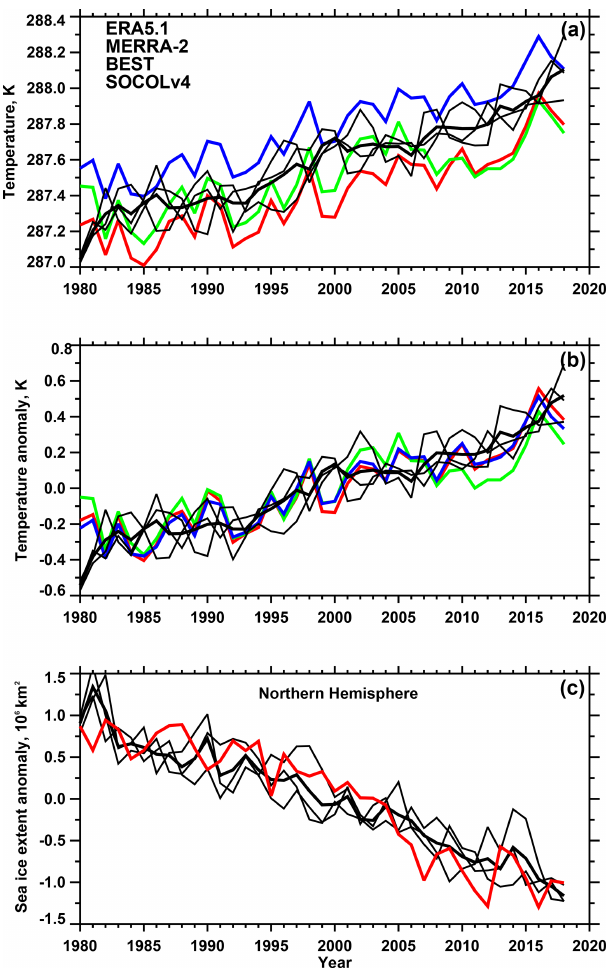
Figure 3. Global and annual mean 2m temperature (a) and its anomalies relative to 1980–2018 mean (b) and Arctic sea ice ex- tent annual anomaly (c) in comparison to reanalysis data. The thick black line represents simulated mean of the three-member SO- COLv4 ensemble, thin black lines are individual ensembles mem- bers, the red line indicates ERA5.1 reanalysis, the green line indi- cates MERRA-2 reanalysis, and the blue line indicates BEST re- analysis.